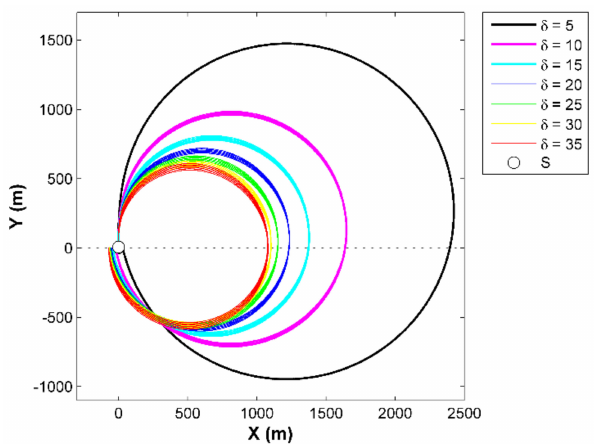
Figure 6. Measurement of 42 trajectories of OS for combination of seven rudder angles and six vessel speeds.